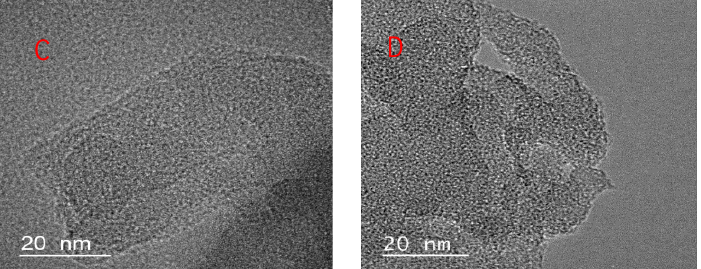
Figure 1. SEM images of ( A ) C 3 N 4 NS and ( B ) 0.4 C ‐ C 3 N 4 NS. High ‐ resolution transmission electron microscope (HRTEM) images of ( C ) C 3 N 4 NS and ( D ) 0.4 C ‐ C 3 N 4 NS.